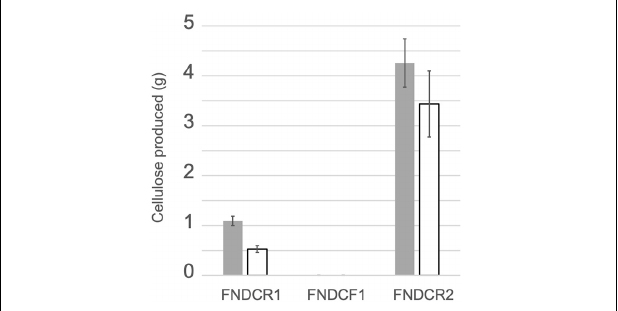
FIGURE 1 | Cellulose productivity of the present strains. Cellulose was produced from glucose (gray bars) or sucrose (open bars) using the designated strains. Quantification results of cellulose from three replicate experiments are shown as mean ± SEM.